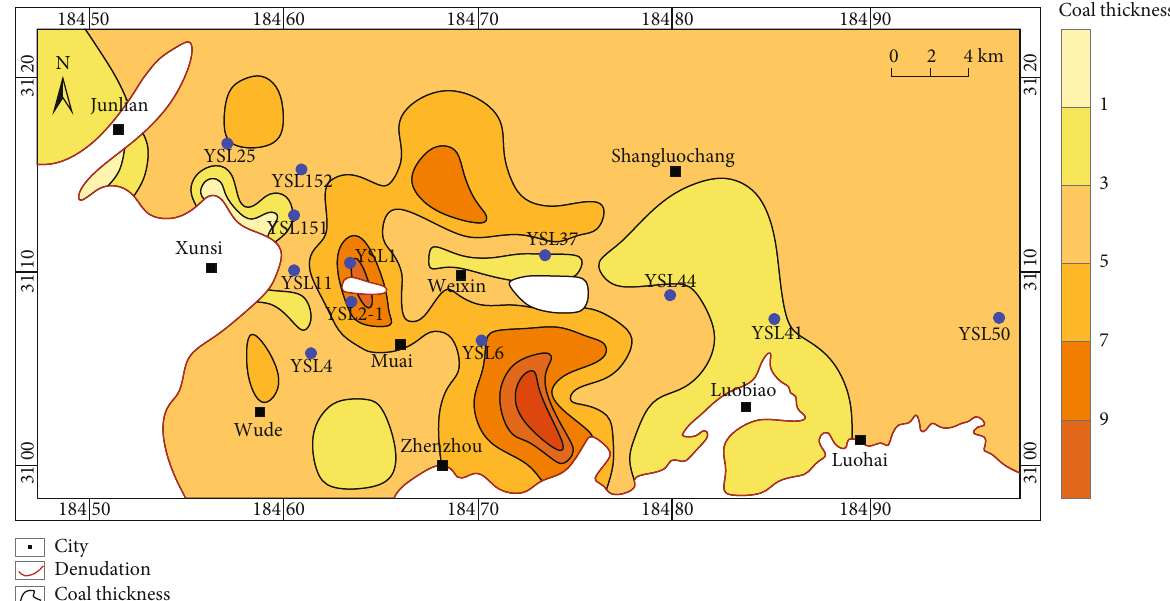
+ C Figure 6: C 7 8 coal seam thickness contour of Junlian.